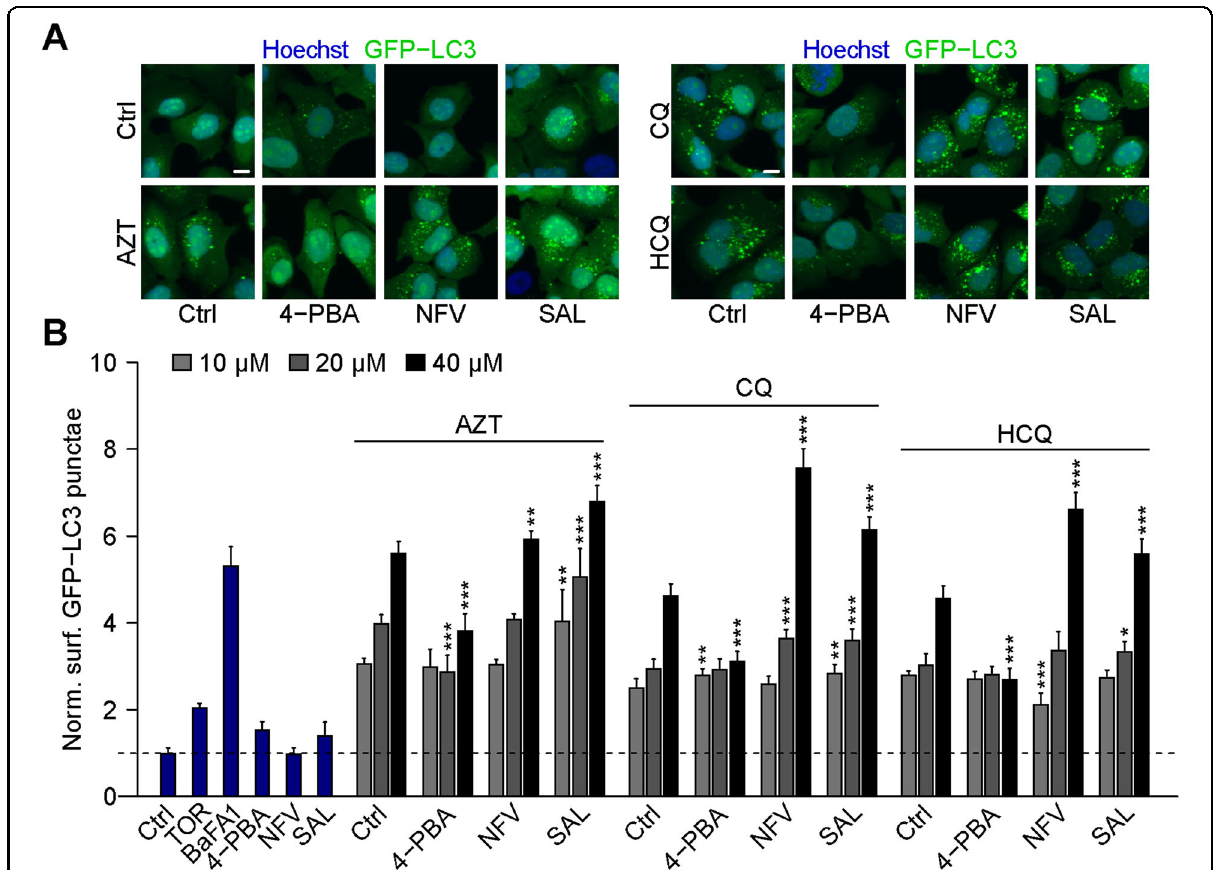
Fig. 4 eIF2 α phosphatase inhibitors increase autophagy induced by chloroquine, hydroxychloroquine, and azithromycin. A , B Human osteosarcoma U2OS cells stably expressing GFP-LC3 were treated with 5 mM 4-phenylbutyric acid (4-PBA), 10 µM nel fi navir (NFV), 25 µM salubrinal (SAL), or were left untreated for 6 h in the presence or absence of 10, 20, 40 μ M chloroquine (CQ), hydroxychloroquine (HCQ), or azithromycin (AZT). After fi xation, GFP-LC3 dot formation was analyzed by microscopy. Torin (TOR) at 300 nM was used as a positive control for autophagy induction and ba fi lomycin A1 (BafA1) at 100 nM was used as an inhibitor of autophagic fl ux. Representative images are depicted in A (AZT, CQ, and HCQ (30 µM) alone or in combination with eIF2 α phosphatase inhibitors) and normalized data are shown as a bar charts in B . Data are means ± SD of four replicates (* P < 0.05, ** P < 0.01 *** P < 0.001 vs. solvent control (Ctrl), Student ’ s t -test). Scale bars equal 10 μ